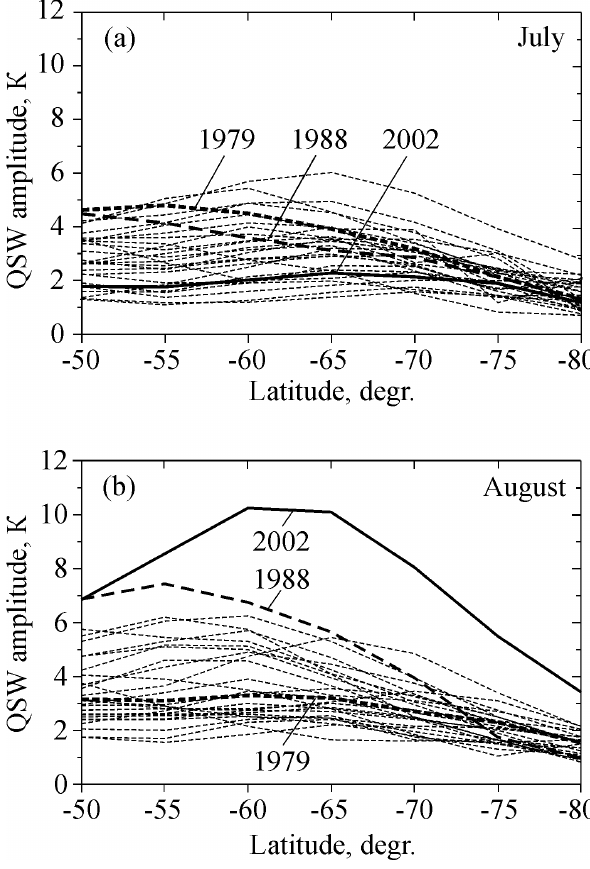
Fig. 6. Interannual variations of the latitudinal distribution of the stationary wave amplitude in the stratosphere temperature at pres- sure level 100hPa in (a) July and (b) August 1979–2006. The two years of anomalously small ozone hole are marked by thick dashed line for 1988 (large warming) and thick solid line for 2002 (major warming). The pre-ozone hole year 1979 is marked by short-dashed thick